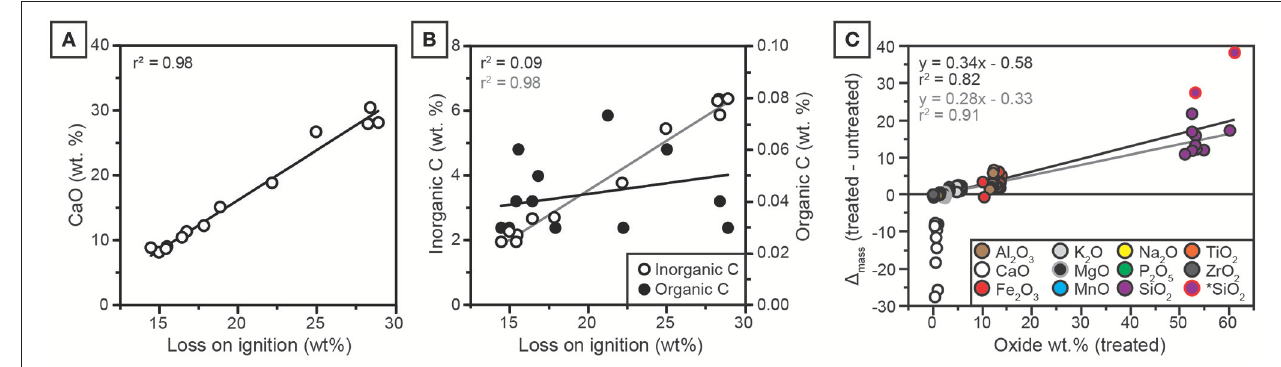
FIGURE 6 | (A) CaO in untreated samples is strongly correlated with loss on ignition (LOI). (B) Inorganic C is strongly correlated with LOI (gray regression line); organic C is very low in abundance and not correlated with LOI (black regression line). (C) Effect of treatment on oxide abundances. The y-axis is the mass change, calculated as decarbonated sample mass minus untreated mass, plotted against mass of treated (decarbonated) samples. Note that mass change scales with oxide abundance for all constituents except CaO. *SiO 2 : Two outlier values with high initial CaO and high SiO 2 mass change, which improve regression statistics when omitted. Black regression was calculated for all samples. Gray regression was calculated omitting two SiO 2 outliers.